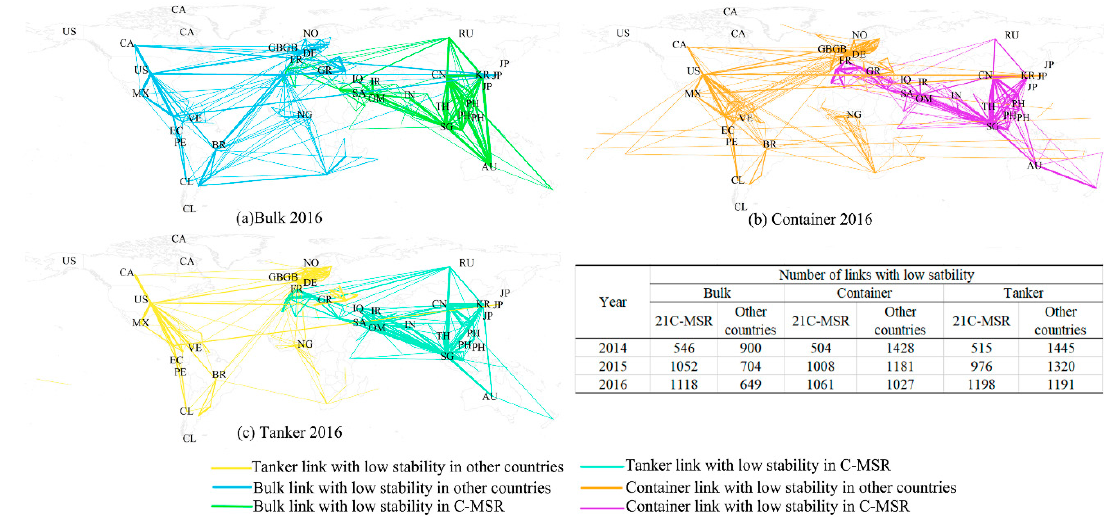
Figure 9. Links with low stability in 21C-MSR and other countries; ( a ) Bulk links with low stability in 2016, ( b ) container links with low stability in 2016, and ( c ) tanker links with low stability in 2016.